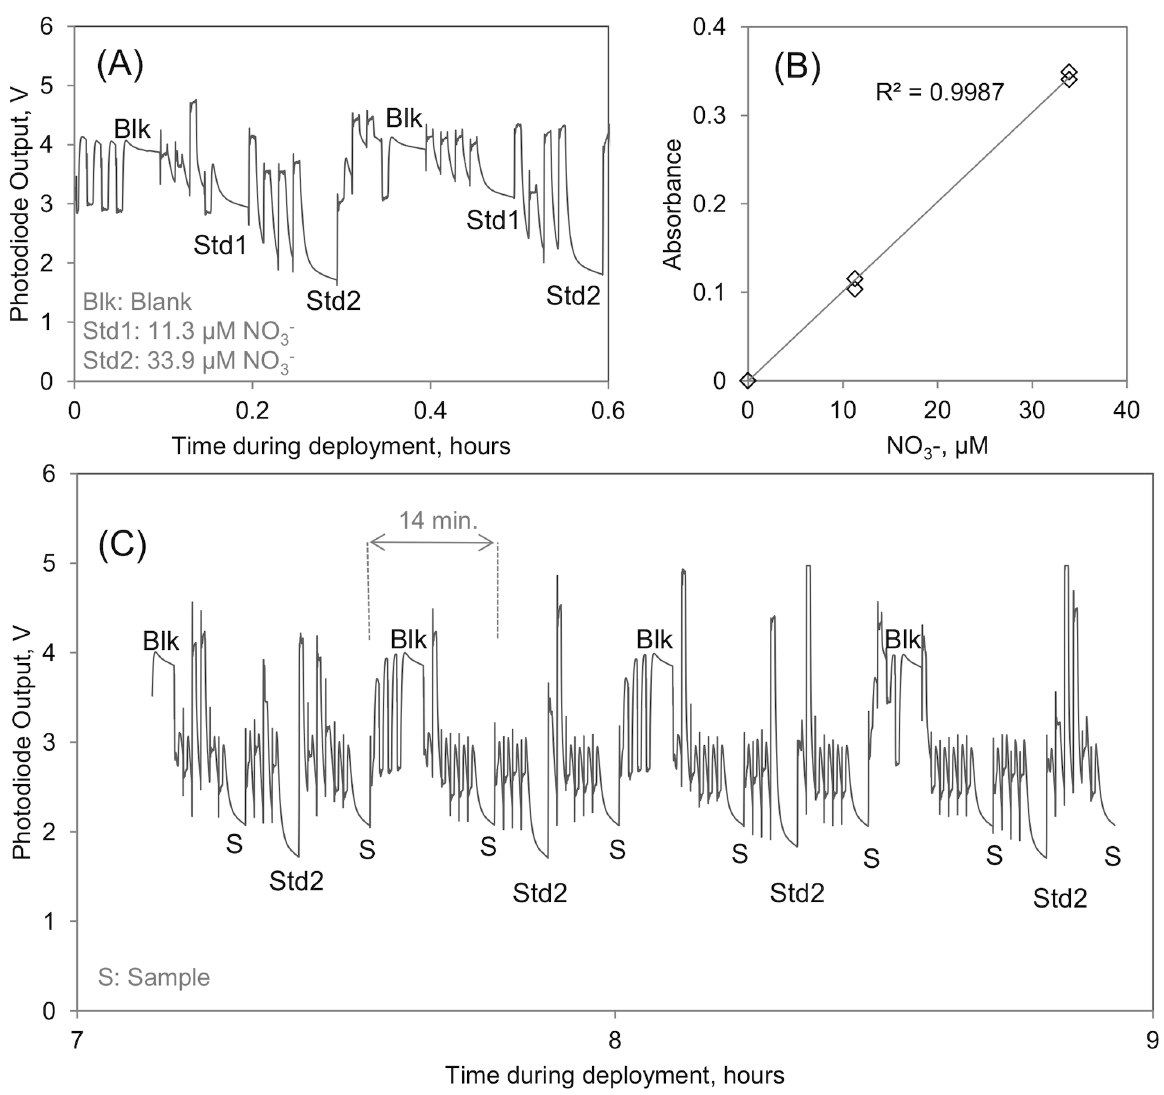
Fig 3. An example of the raw output of the lab-on-chip nitrate sensor. (A) Photodiode output showing the two sets of calibration performed in situ in the beginning of the series at 170 m depth. After the measurement of a blank (Blk), two standards solutions of NO 3- (Std1 and Std2) were measured and the calibration plot in (B) was obtained. Panel (C) shows an excerpt of the photodiode output during the same time series at 170 m depth, 7 – 9 hours after the first measurement. Blank solutions and the 33.9 μ M standard solution were regularly measured in between sample (S) measurements, The fluctuating voltages were recorded during the flushing of the microfluidic chip and do not affect the measurements